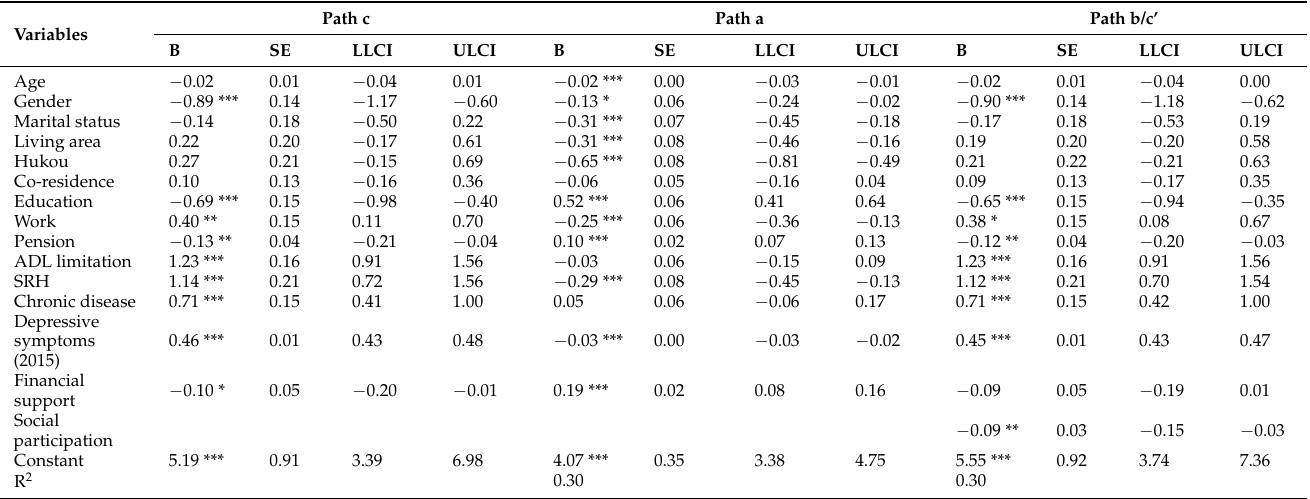
Table 4. Longitudinal mediating effect of social participation in the association between financial support and depressive